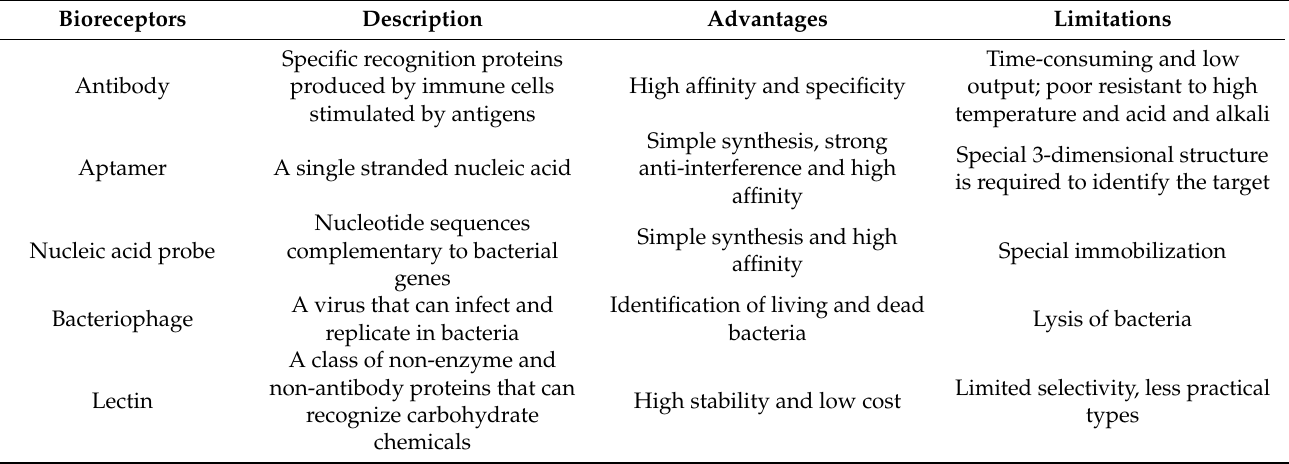
Table 1. Summary of bioreceptors for Salmonella